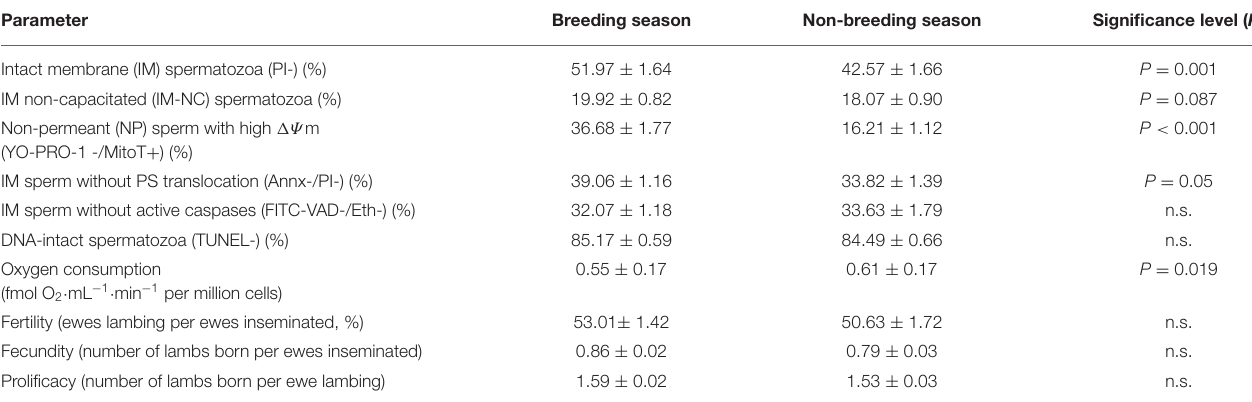
TABLE 2 | Differences in analyzed parameters between seminal doses from the breeding and the non-breeding season.